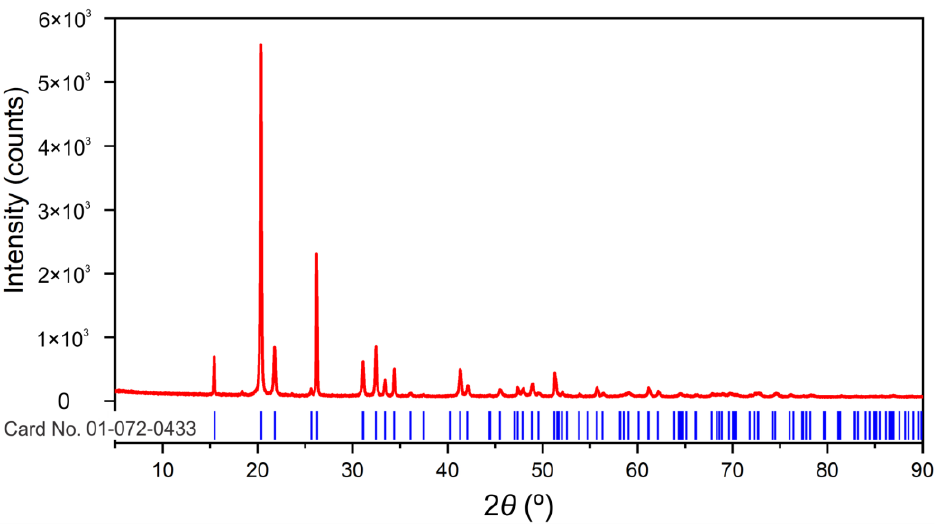
Figure 2. Experimental XRPD pattern in red. Peak positions for Shcherbinaite, V 2 O 5 (card number 01-072-0433; ICDD (PDF-2 Release 2016 RDB)) in blue are shown below the experimental pattern.